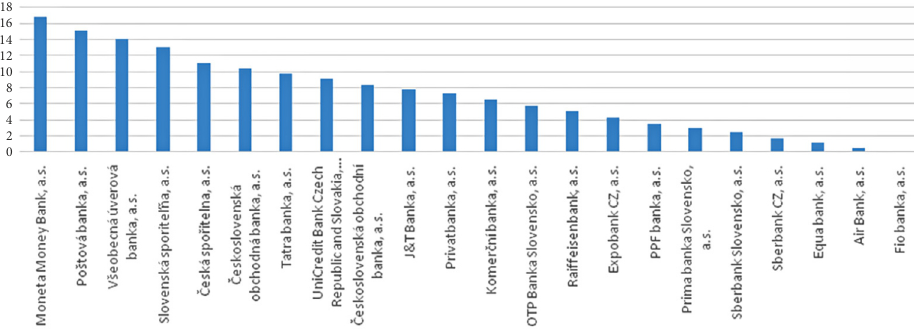
Fig. 6. Ranking of the analyzed Czech and Slovak banks according to MAPPAC